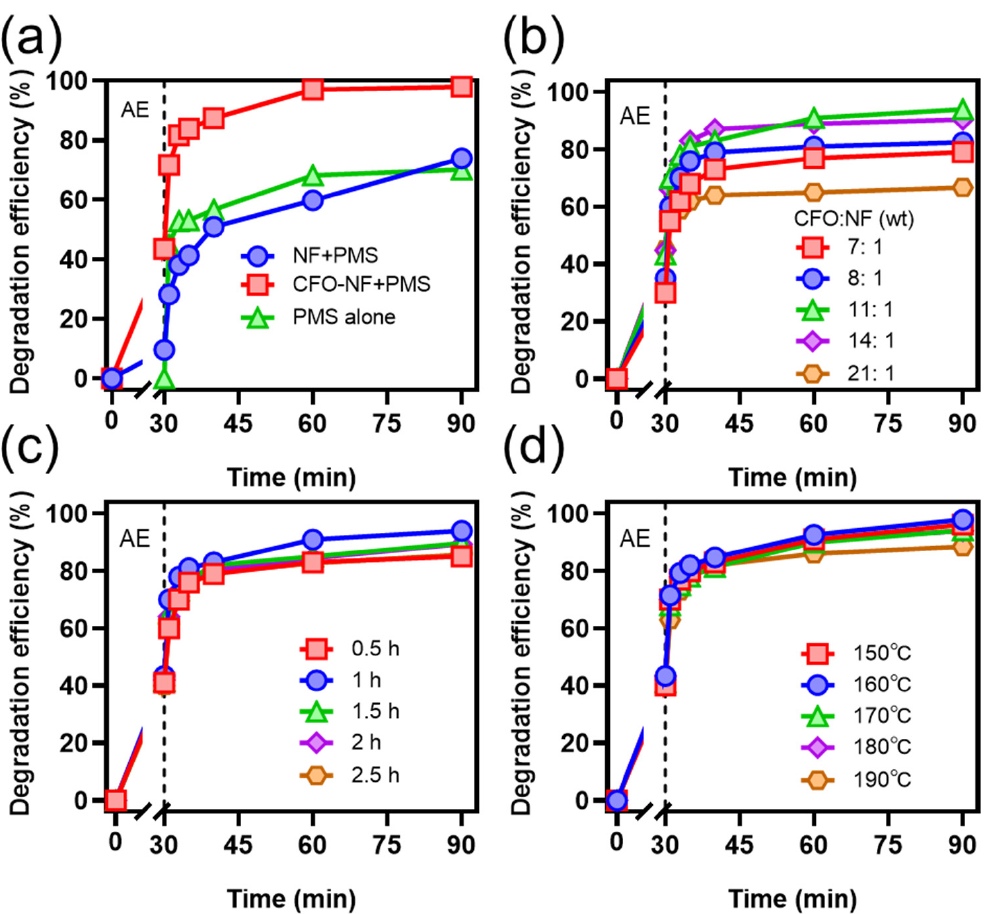
Figure 3. Effect of ( a ) different systems (PMS: 0.4 mM, TC: 10 mg L − 1 , catalysts: 4 pieces, 25 °C), ( b ) the mass ratio of CFO to NF, ( c ) hydrothermal time (180 °C), and ( d ) hydrothermal temperature on TC degradation efficiency (( b – d ): PMS: 0.7 mM, TC: 10 mg L − 1 , catalysts: 4 pieces, 25 °C) (Note: AE represents adsorption equilibrium).